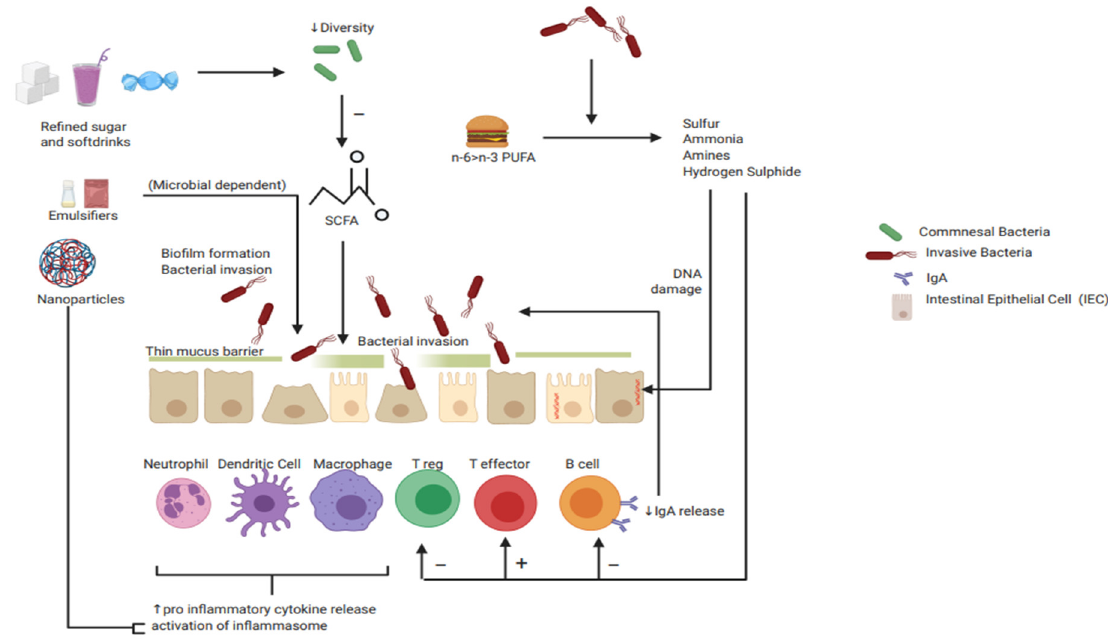
Figure 2. Schematic representation of proposed mechanisms of pathological diet-immune interactions that may contribute to IBD risk and disease activity. (Created with BioRender). Abbreviations: polyunsaturated fatty acid (PUFA), short-chain fatty acid (SCFA), Ig (Immunoglobulin).